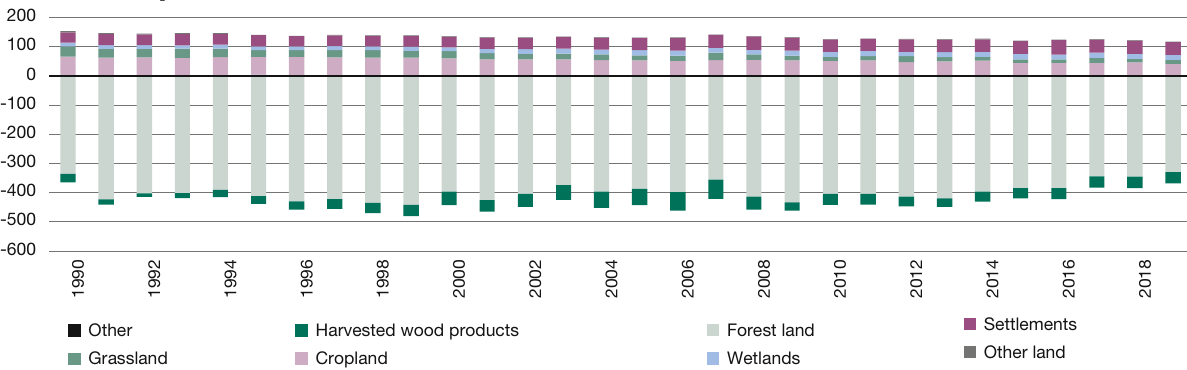
Land use, land-use change and forestry sector emissions and removals in the EU, by main land use category